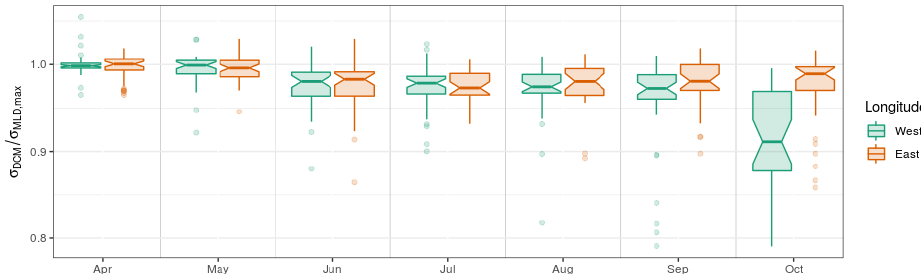
Figure 8. Ratio between the σ DCM of individual profiles and the maximum σ MLD recorded by the same float during the same year. West and east longitude are defined with respect to the meridian of 34.5 ◦